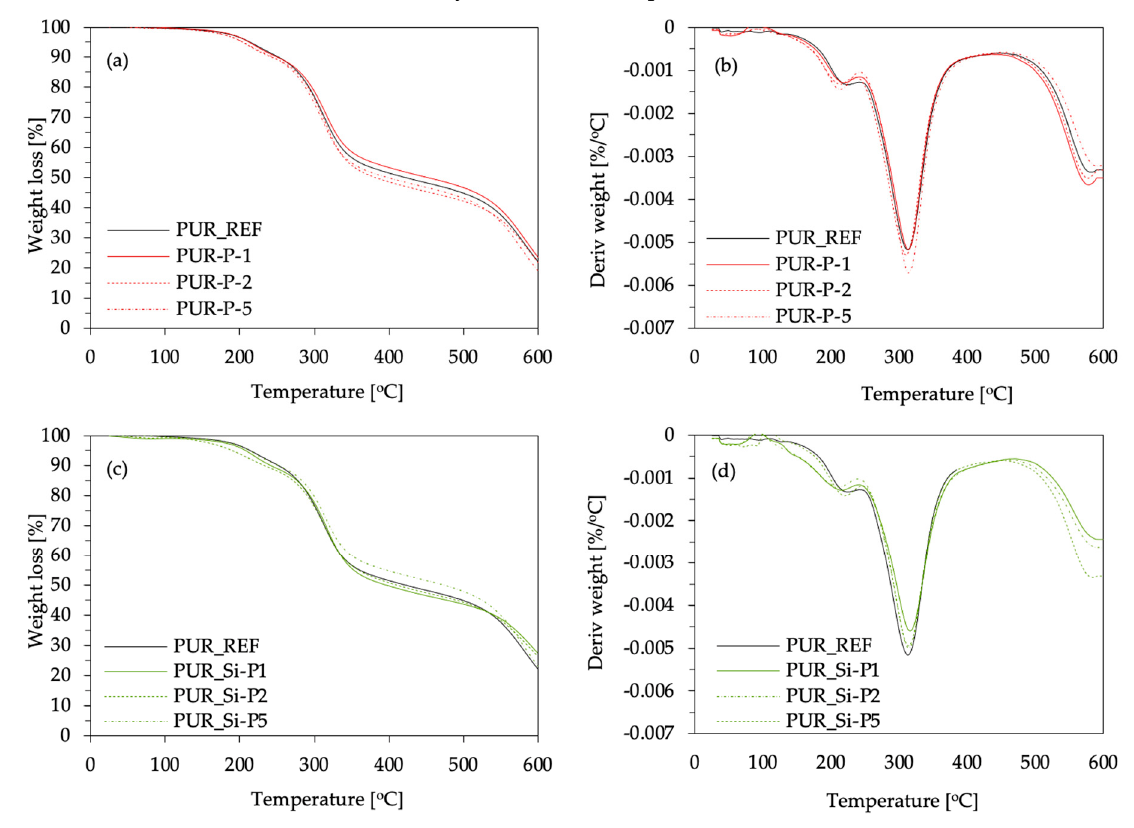
Figure 7. Thermogravimetric (TGA) and derivative thermogravimetry (DTG) results obtained for UR foams modified with ( a , b ) plum fillers and ( c , d ) silanized plum fillers.